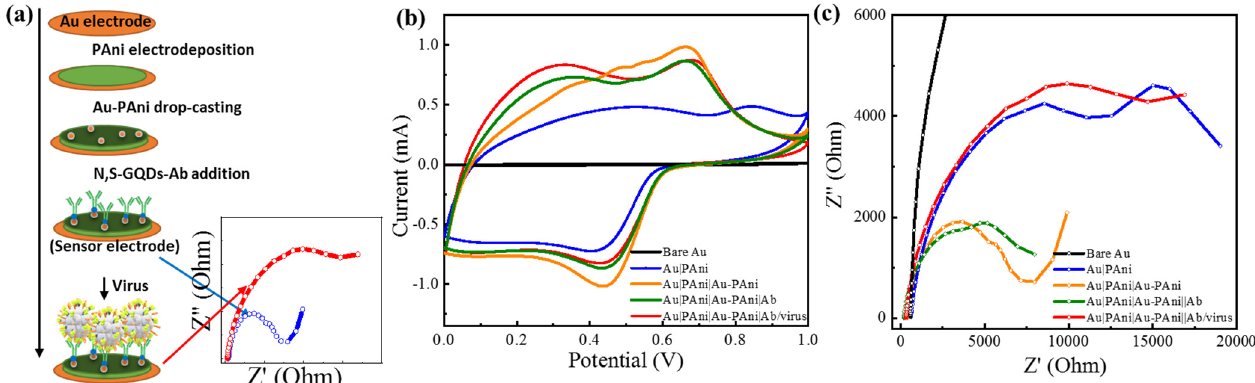
Figure 1. ( a ) Schematic diagram of the stepwise preparation of the sensor electrode, ( b ) cyclic voltammetry, and ( c ) electrochemical impedance results of Au|PAni|Au-PAni-Ab electrode before and after virus addition.